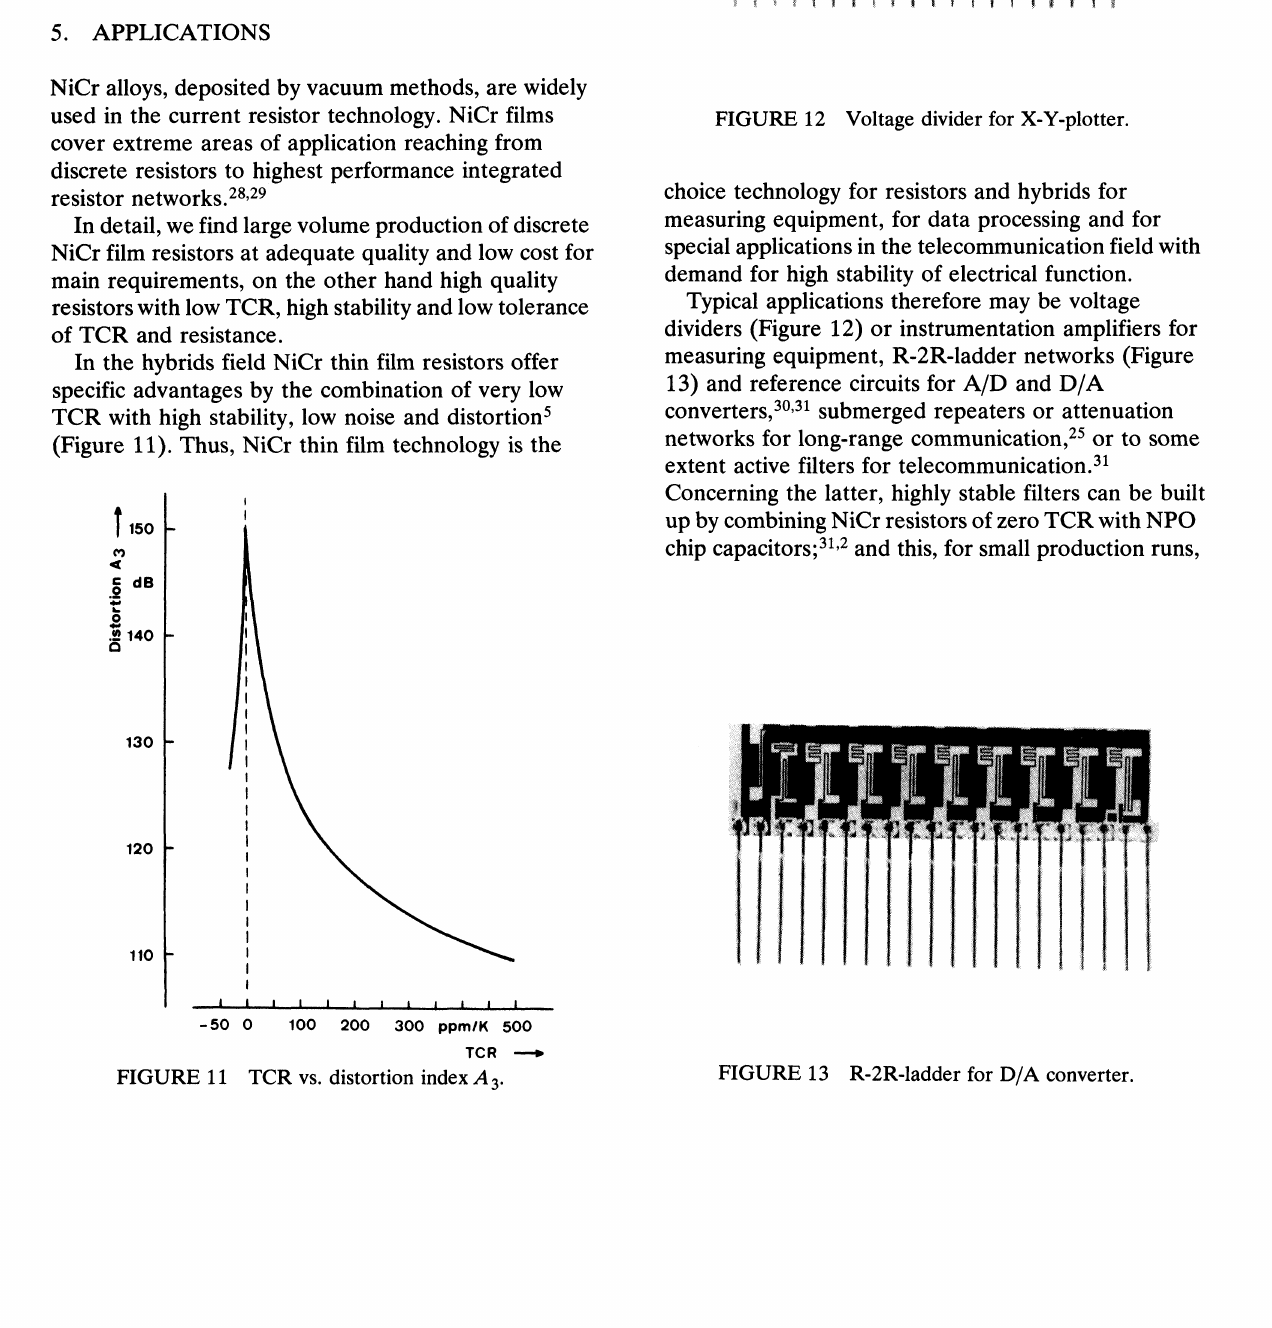
FIGURE 11 TCR vs. distortion index A